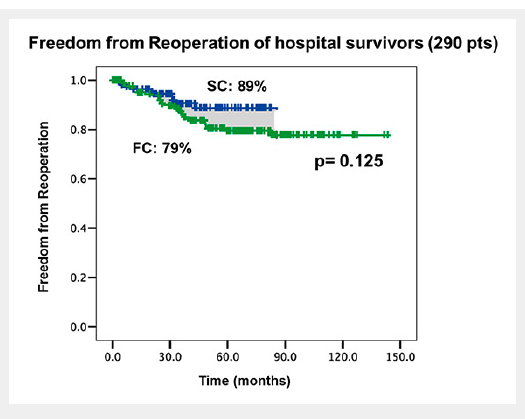
Disease free survival of hospital survivors (290 patients); SC: blue; FC: green.